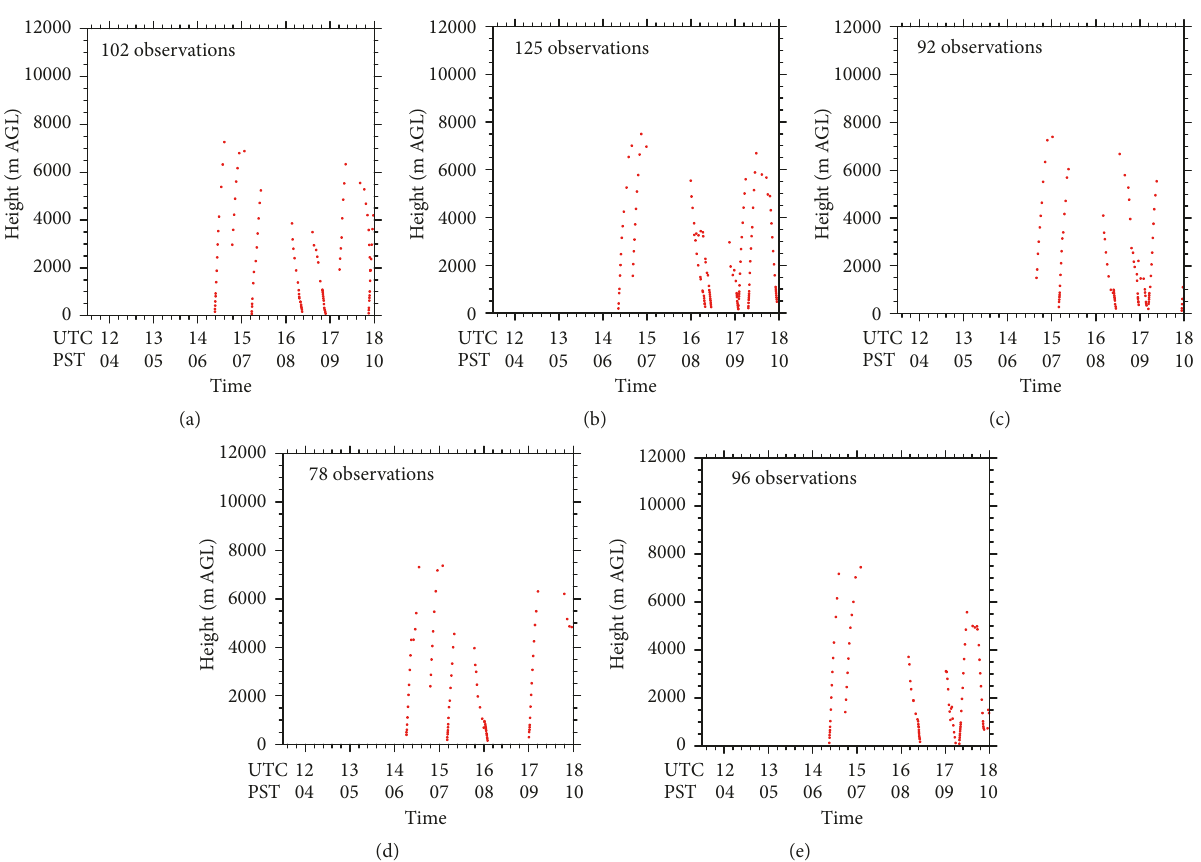
Figure 3: Time-height distribution of TAMDAR observations over the 1km WRF-ARW domain during the assimilation period (12–18 UTC) for the following dates in 2012: (a) 7 February, (b) 9 February, (c) 16 February, (d) 1 March, and (e) 5